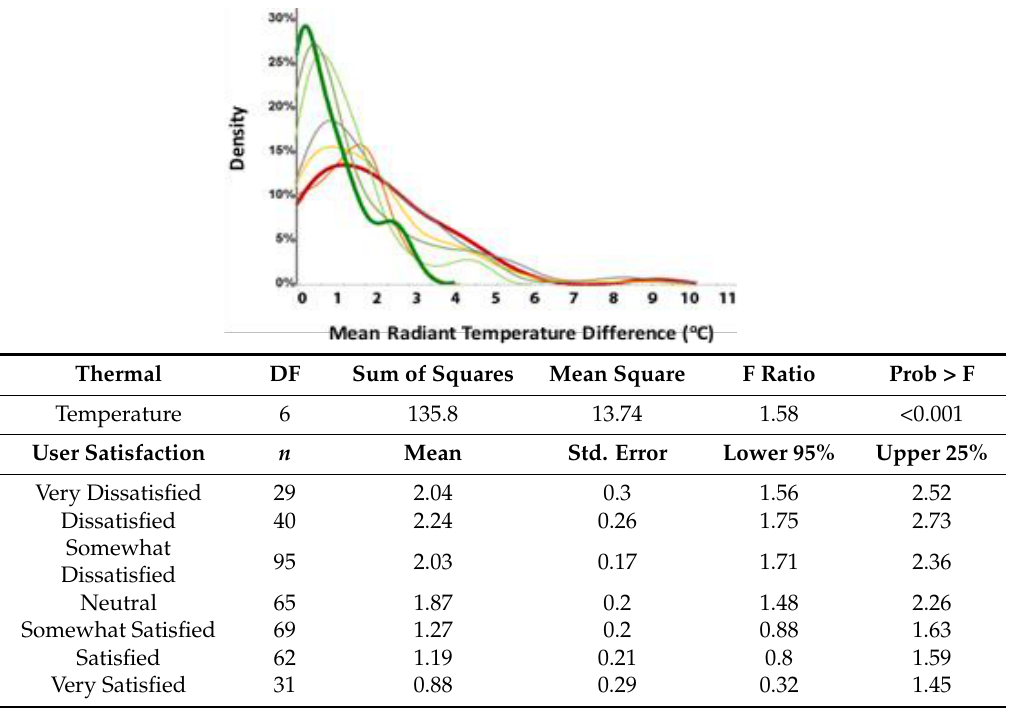
Table 14. Density comparisons: radiant temperature asymmetry between the exterior and interior walls in perimeter offices ( n = 391).